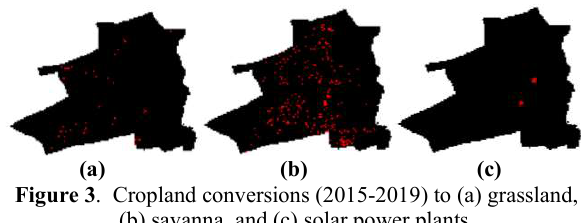
Figure 3 . Cropland conversions (2015-2019) to (a) grassland, (b) savanna, and (c) solar power plants.